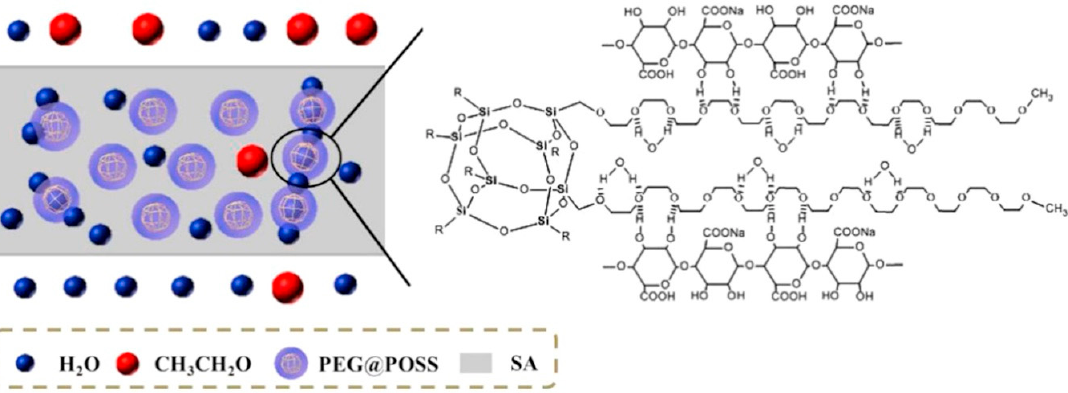
Figure 4. Schematic depiction of water permeation in nanocomposite PEG@POSS-SA membrane. Taken from Wang et al. [46].